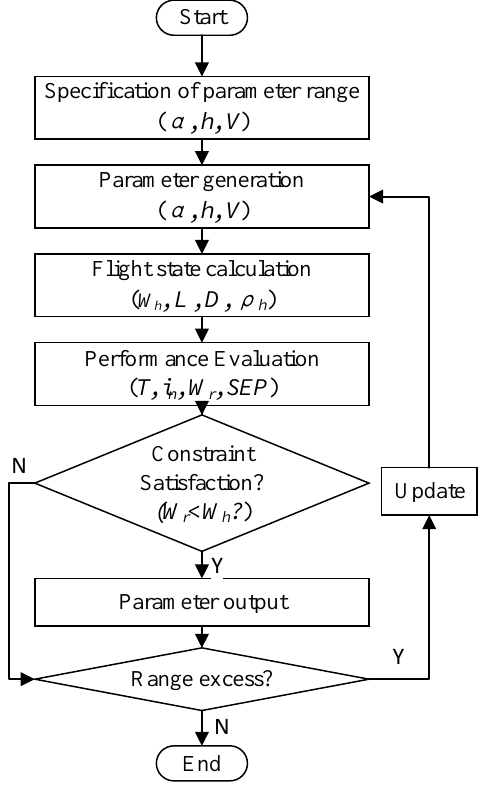
Figure 6. The flowchart of 3D flight envelope calculation method.